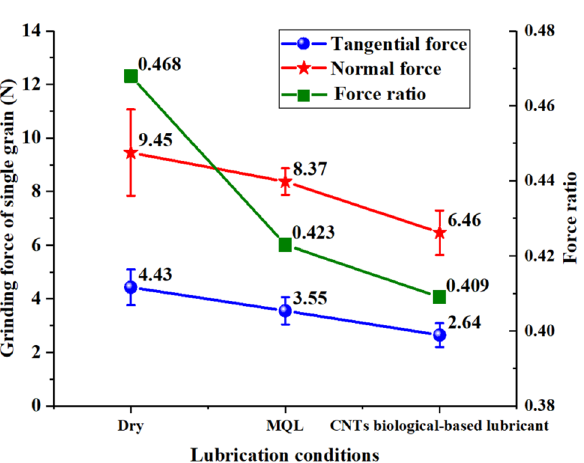
Figure 7. Grinding force and force ratio of single grain grinding under different lubrication conditions. Figures were created using the Origin (version